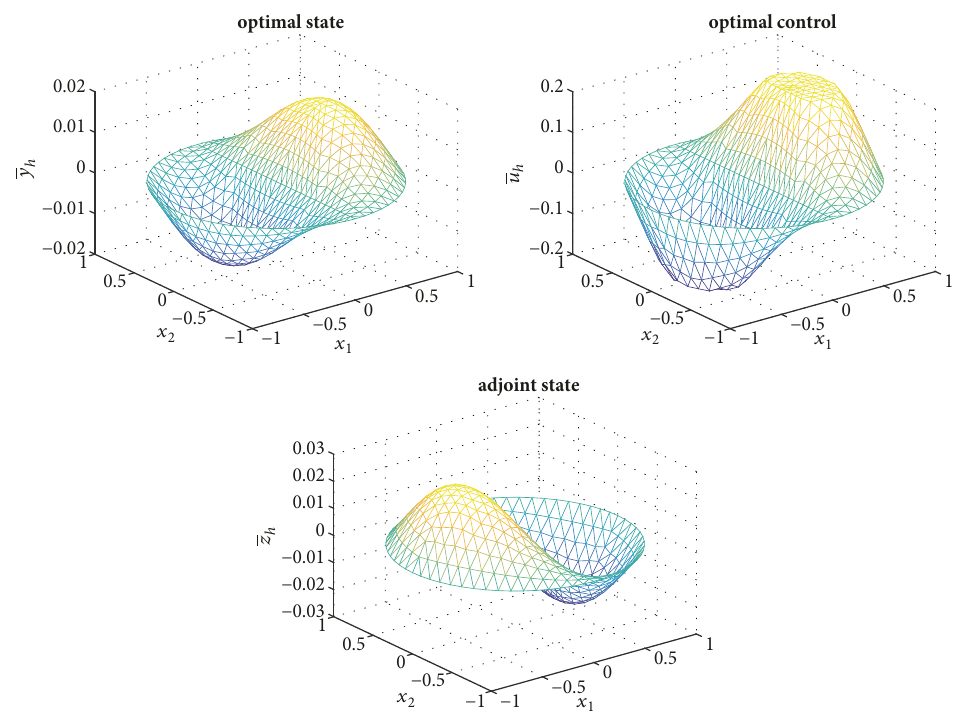
Figure 5: Numerical results of Experiment 2: optimal state, optimal control, and corresponding adjoint state.